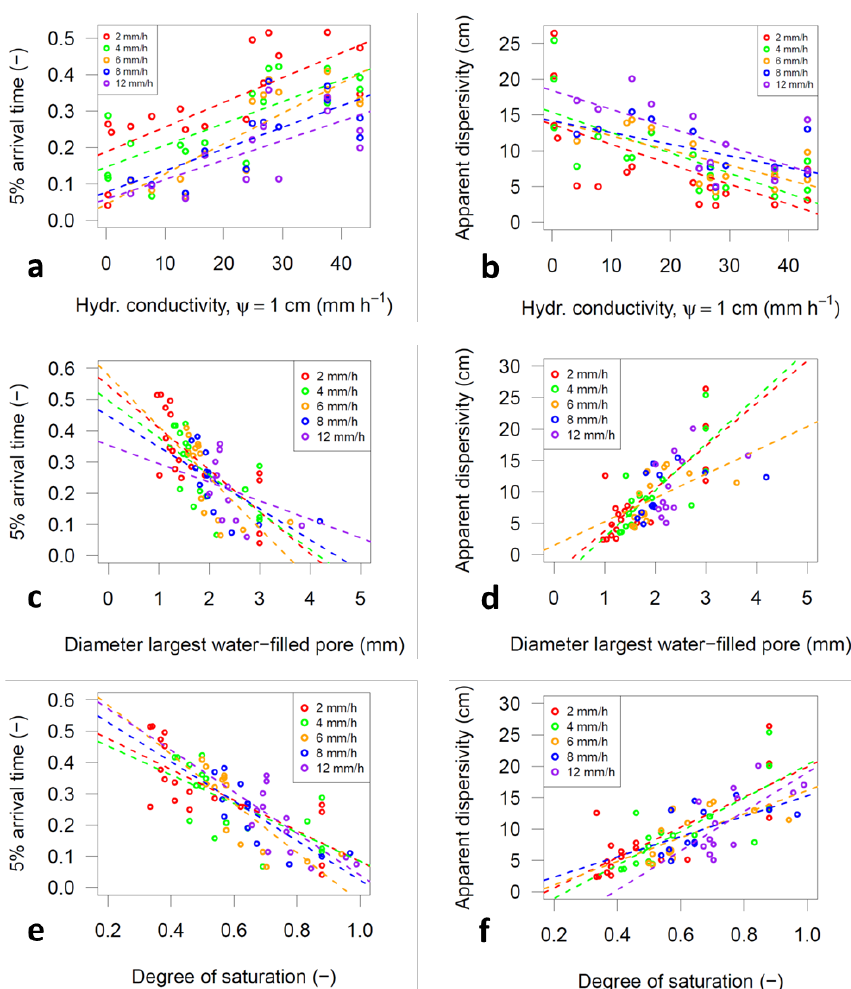
Figure 10. Relationship between hydraulic conductivity at ψ = 1cm, the diameter of the largest water-filled pore, the degree of saturation in the macropores and measures of preferential transport for the four soils. Linear regression lines (dashed) were drawn if the slope was significantly ( p value <0.05) different from zero.